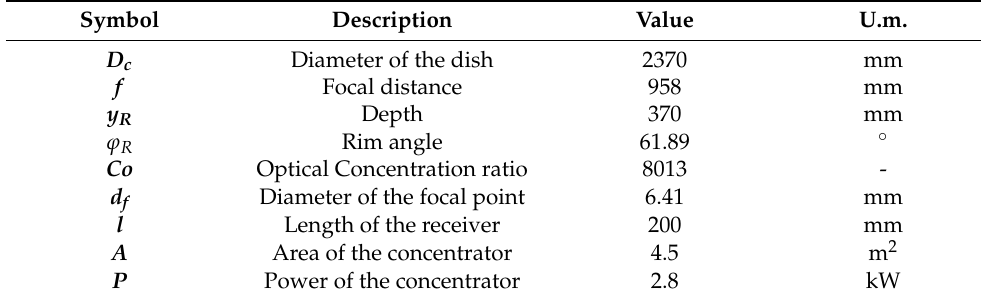
Table 1. Features of the solar dish